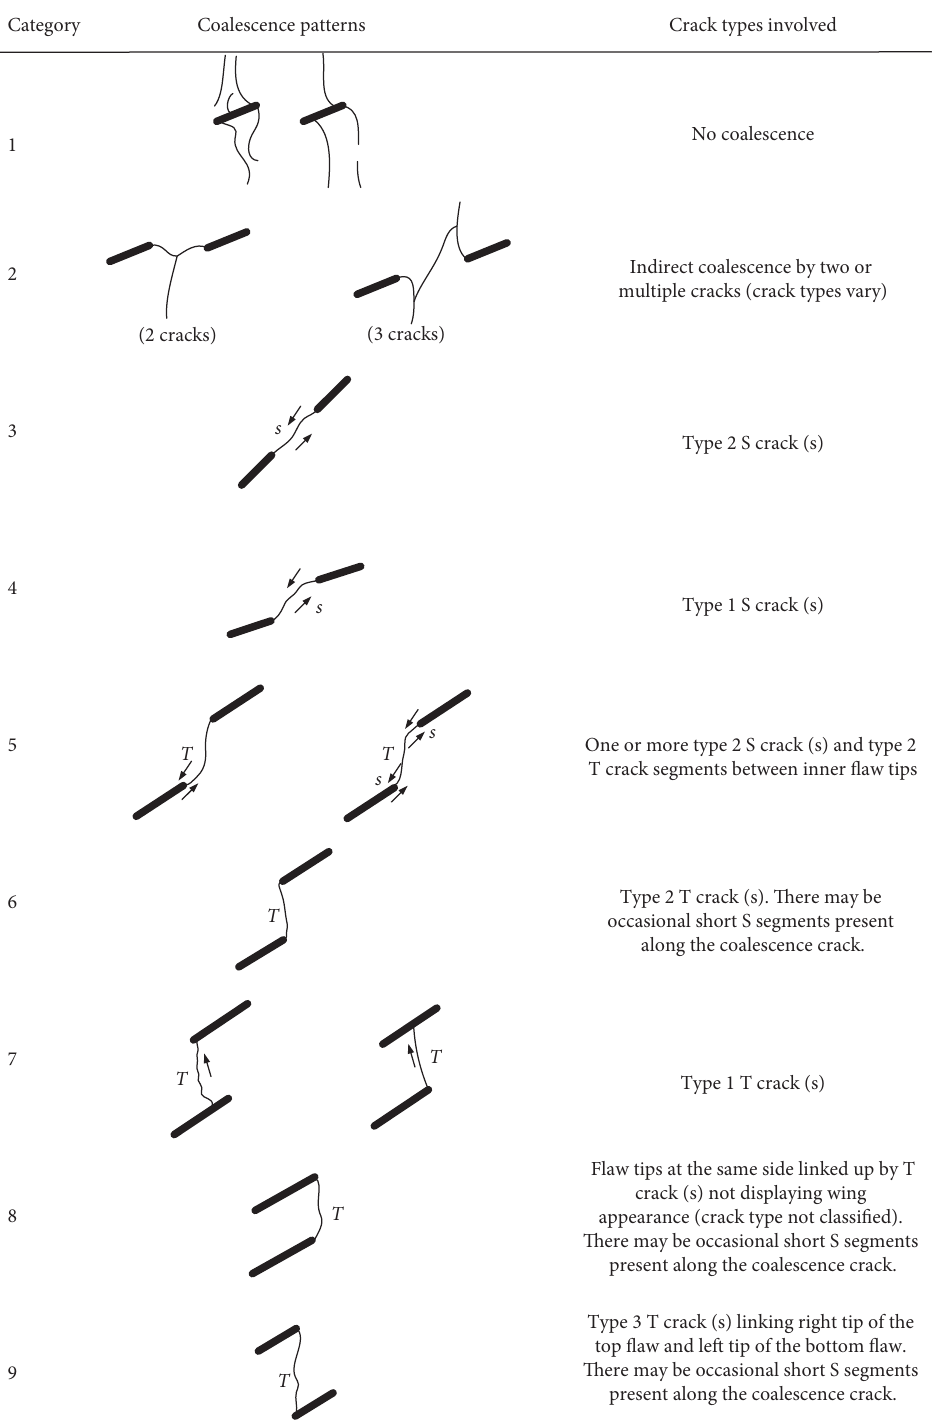
Figure 2: Classification of crack coalescence categories (Wong’s classification